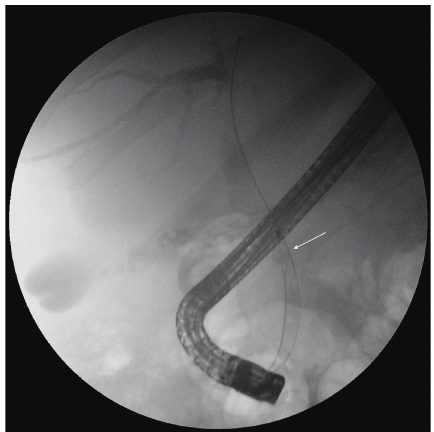
Figure 2: ERCP demonstrating the biliary extraction basket around a stone (arrow) within the CBD.